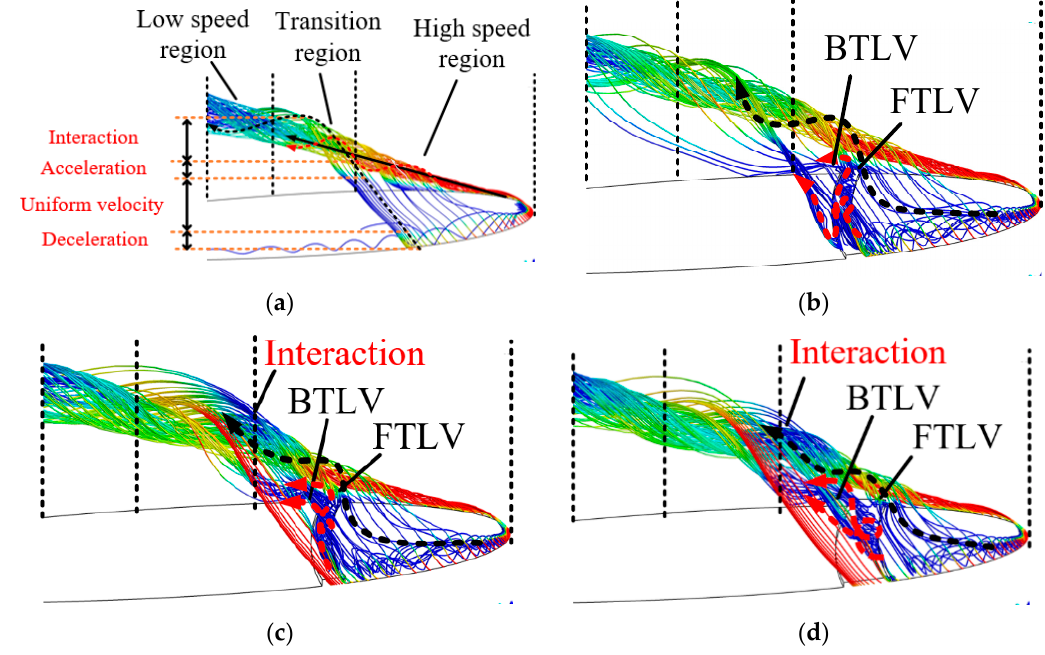
Figure 11. Streamline at the blade tip. ( a ) Origin Case, ( b ) Case A, ( c ) Case B, ( d ) Case C.